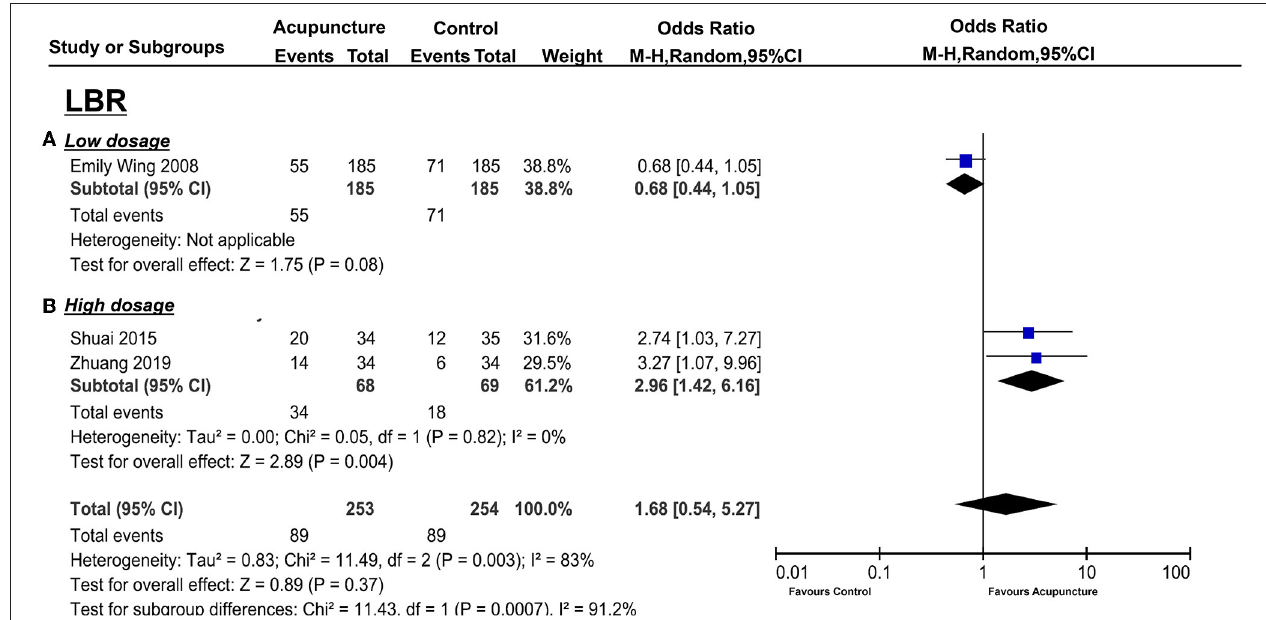
FIGURE 7 | Effects of acupuncture on LBR based on intervention of low dosage (A) and high dosage (B) .